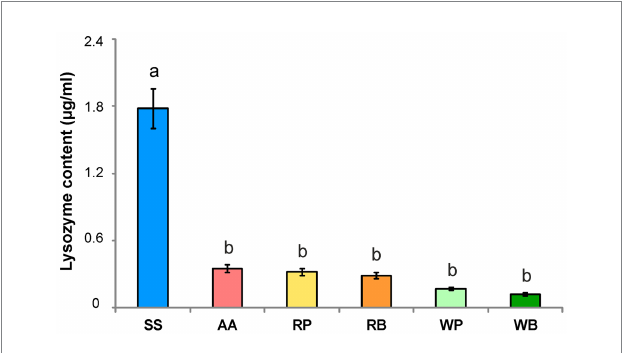
FIGURE 6 Lysozyme content ( μ g/ml) in the hemolymph of worker bees consuming different diets. SS, sucrose solution (control group); AA, sucrose solution + amino acids; RP, sucrose solution + rapeseed pollen; RB, sucrose solution + rapeseed beebread; WP, sucrose solution + willow pollen; WB, sucrose solution + willow beebread. Different letters indicate significant differences between the values ( p <